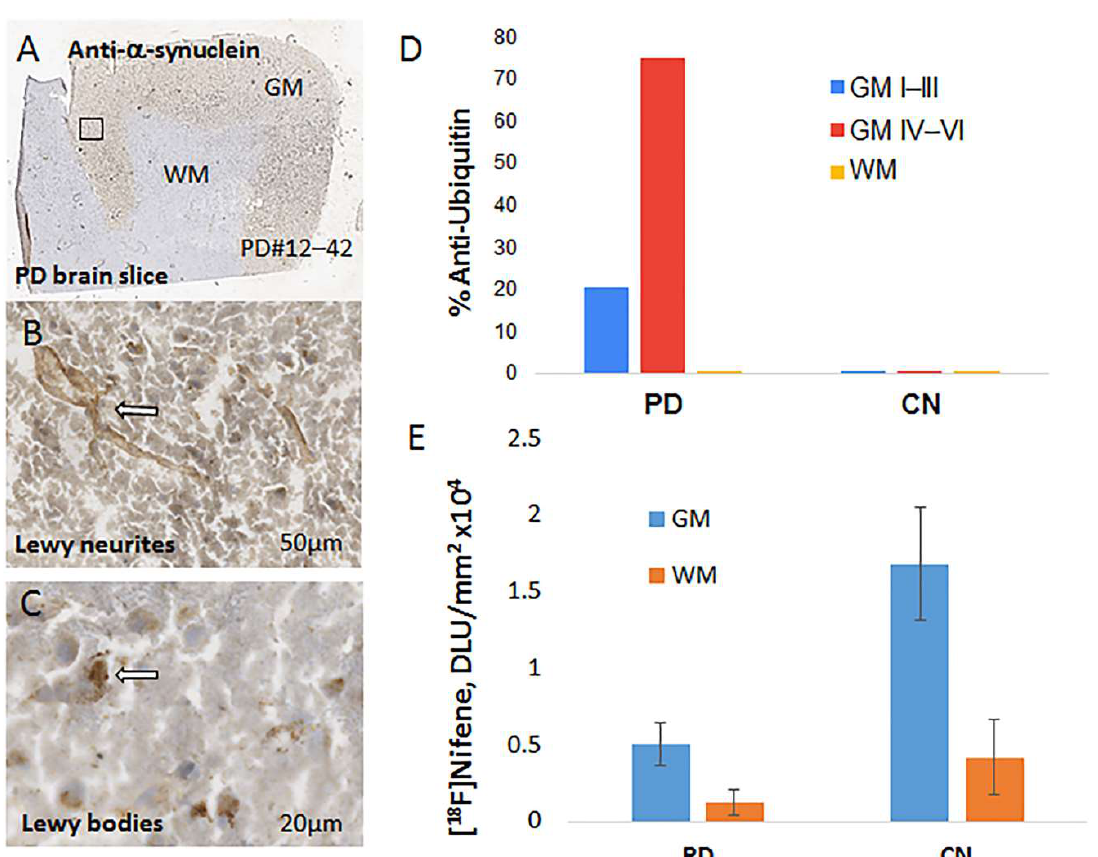
Figure 9. ( A ) Anti- α -synuclein IHC of PD brain slice; ( B ) magnified view at 50 µ m showing presence of Lewy neurites; ( C ) Lewy bodies stained for α -synuclein in Lewy bodies see at 20 µ m; ( D ) anti-ubiquitin staining showing presence of Lewy bodies in the PD and absent in the CN brains ( p < 0.001). Cortical layers IV–VI had significantly greater amounts compared to outer I–III layers. White matter did not reveal presence of Lewy bodies; ( E ) comparison of [ 18 F]nifene in post-mortem human PD versus controls showing decreases in PD GM ( p < 0.01).